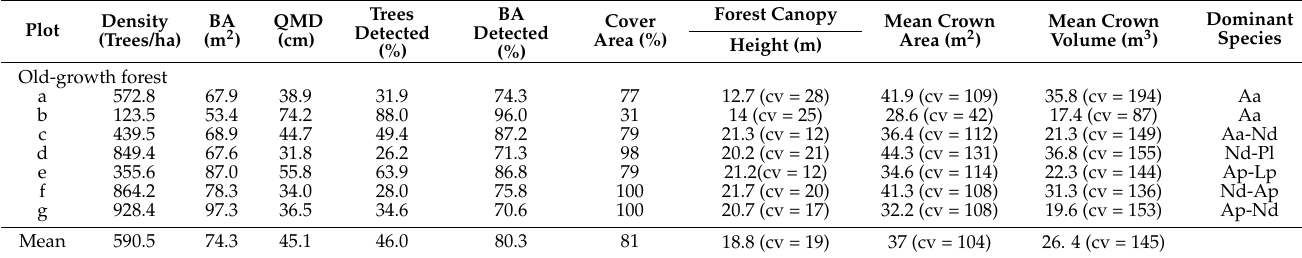
Figure 1. Location of the sites and illustration of the steps performed in the acquisition and processing of the data. ( A ) Image acquisition; ( B ) structure from motion (SfM); ( C ) illustration of SfM estimation of the digital surface model (DSM); ( D ) position of every individual-tree DBH over 5 cm, over the high-resolution mosaic of the stand; ( E ) DSM of the stand; ( F ) association of each tree crown with its field measurements; ( G ) the study site. Table 1. Stand variables, dominant species, and structure of the plots (ground data). QMD, observed quadratic mean diameter. The mean and standard deviation of crow area and volume were calculated with visible canopy imagery from the UAV. Density, basal area, and QMD with all the trees. Trees and BA detected are the reason between the visible canopy and stand values. Aa, Araucaria araucana; Nd, Nothofagus dombeyi ; Pl, Persea lingue ; Ap, Aextoxicon punctatum; Lp, Laureliopsis philippiana; No, N. obliqua; Ec, Eucryphia cordifolia